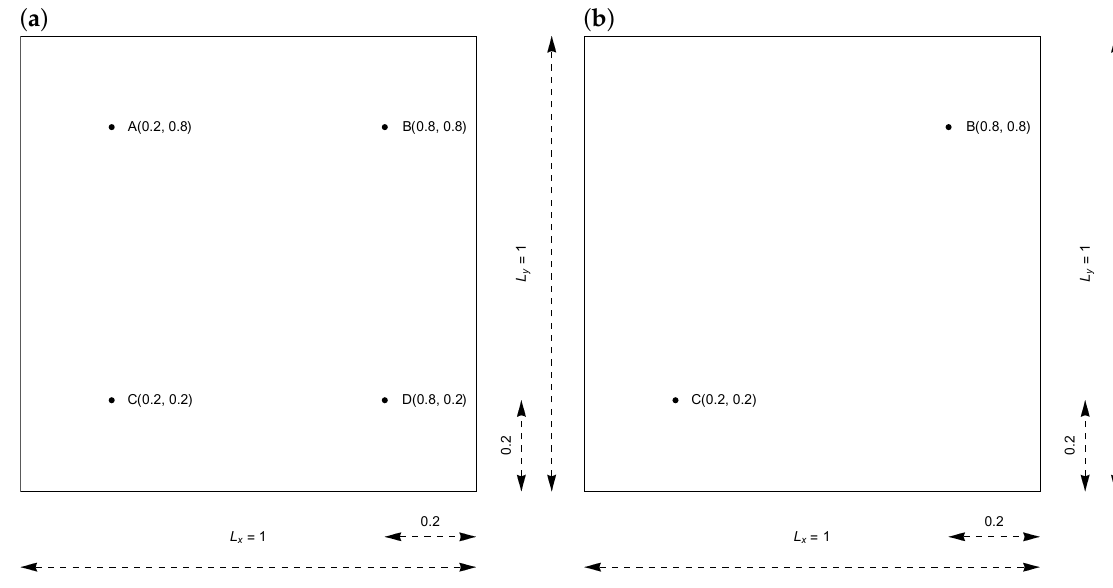
Figure 1. Locations of the measurement points in cases of ( a ) four measurement points; ( b ) two measurement